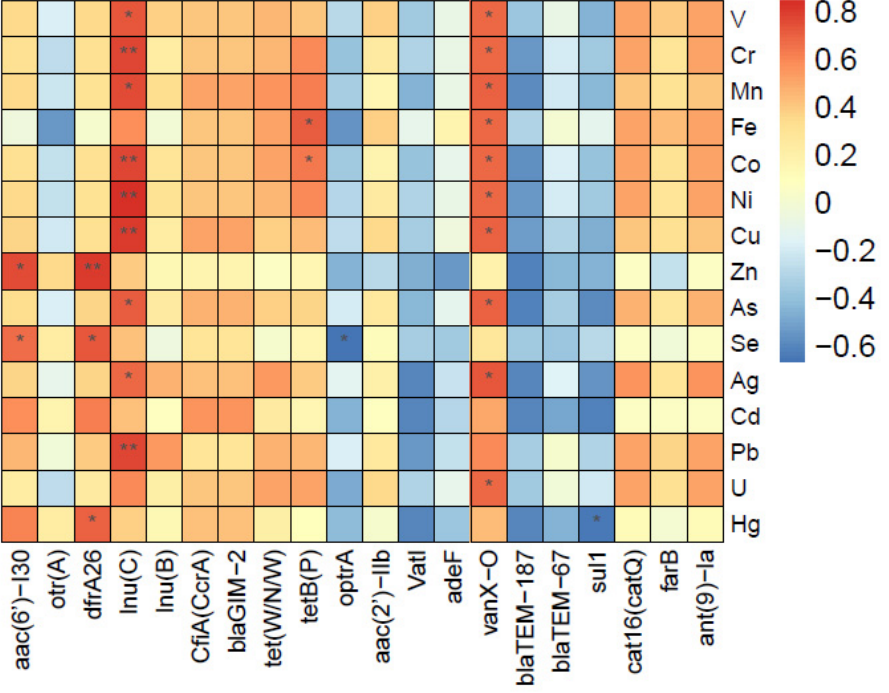
Figure 9. Heatmap of relative abundance of ARGs with heavy metals. *: significant difference, p < 0.05; **: highly significant difference, p < 0.01.